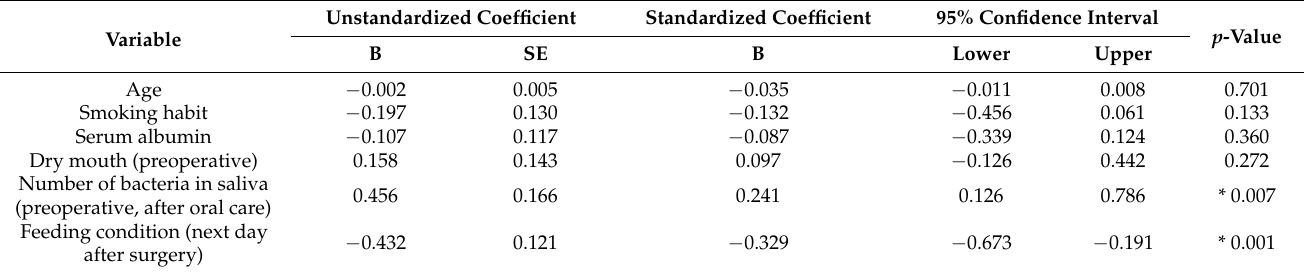
Table 5. Factors related to the number of bacteria in saliva on the day after surgery (multivariate